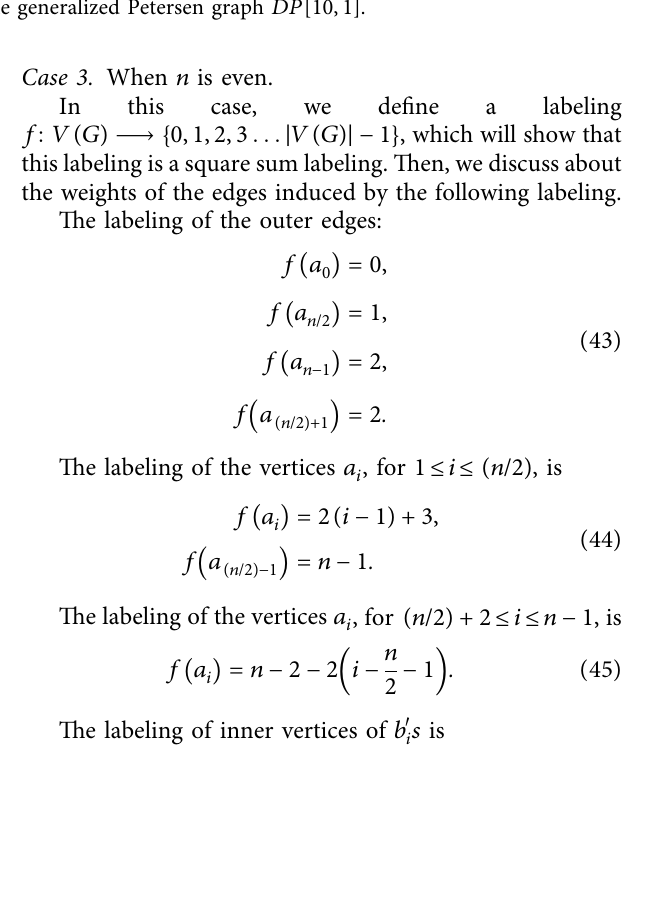
Figure 4: Square sum labeling of double generalized Petersen graph DP [ 10 , 1 ]